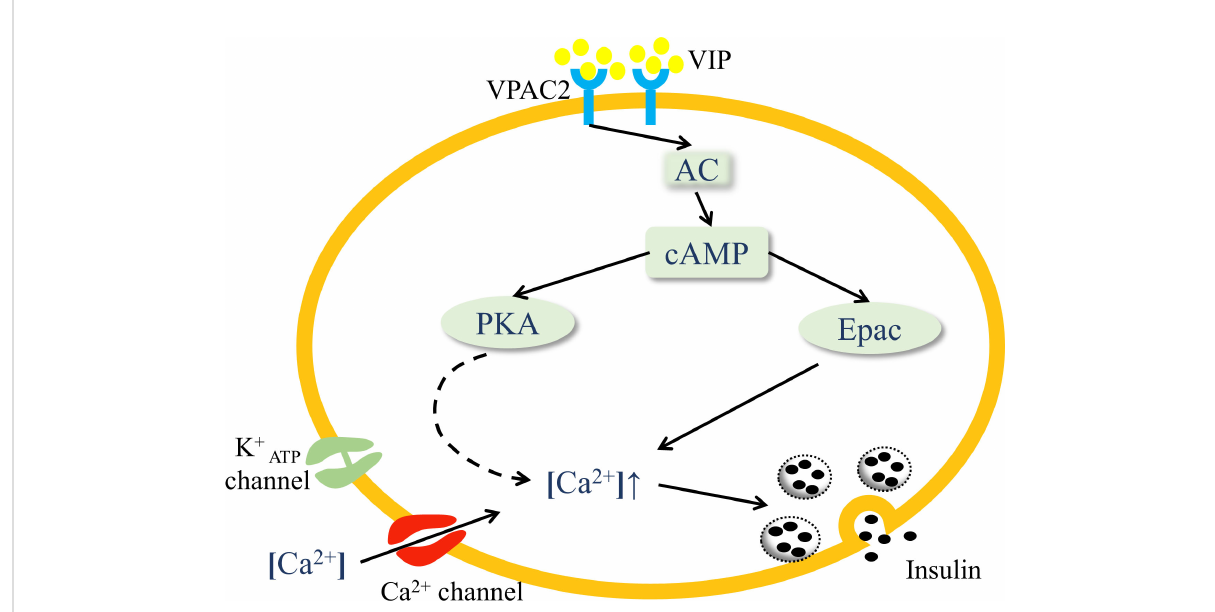
FIGURE 1 VIP activates the VPAC2 signaling pathway in pancreatic islets. VIP binding to VPAC2 receptors on b -cells activates AC and increases the concentration of cAMP, which activates PKA and the Epac family. PKA triggers the closure of ATP-dependent K + channels, resulting in plasma membrane depolarization, and the opening of voltage-gated Ca 2+ channels, which leads to an increased in fl ux of Ca 2+ . Activation of Epac mobilizes the release of Ca 2+ from internal storage. Both the processes cause elevated intracellular Ca 2+ levels and the release of insulin through